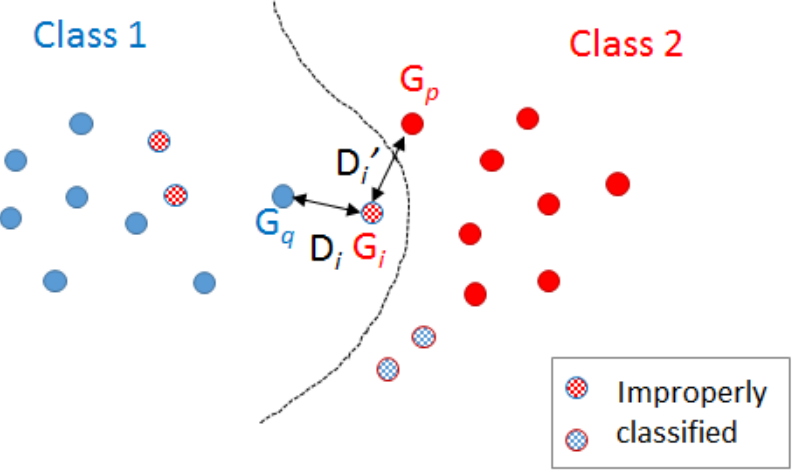
Figure 4. Stripped molecules have been improperly classified using NN strategy. G i is the one that (cid:48) − D > D minimises D (cid:48) j being D j j j